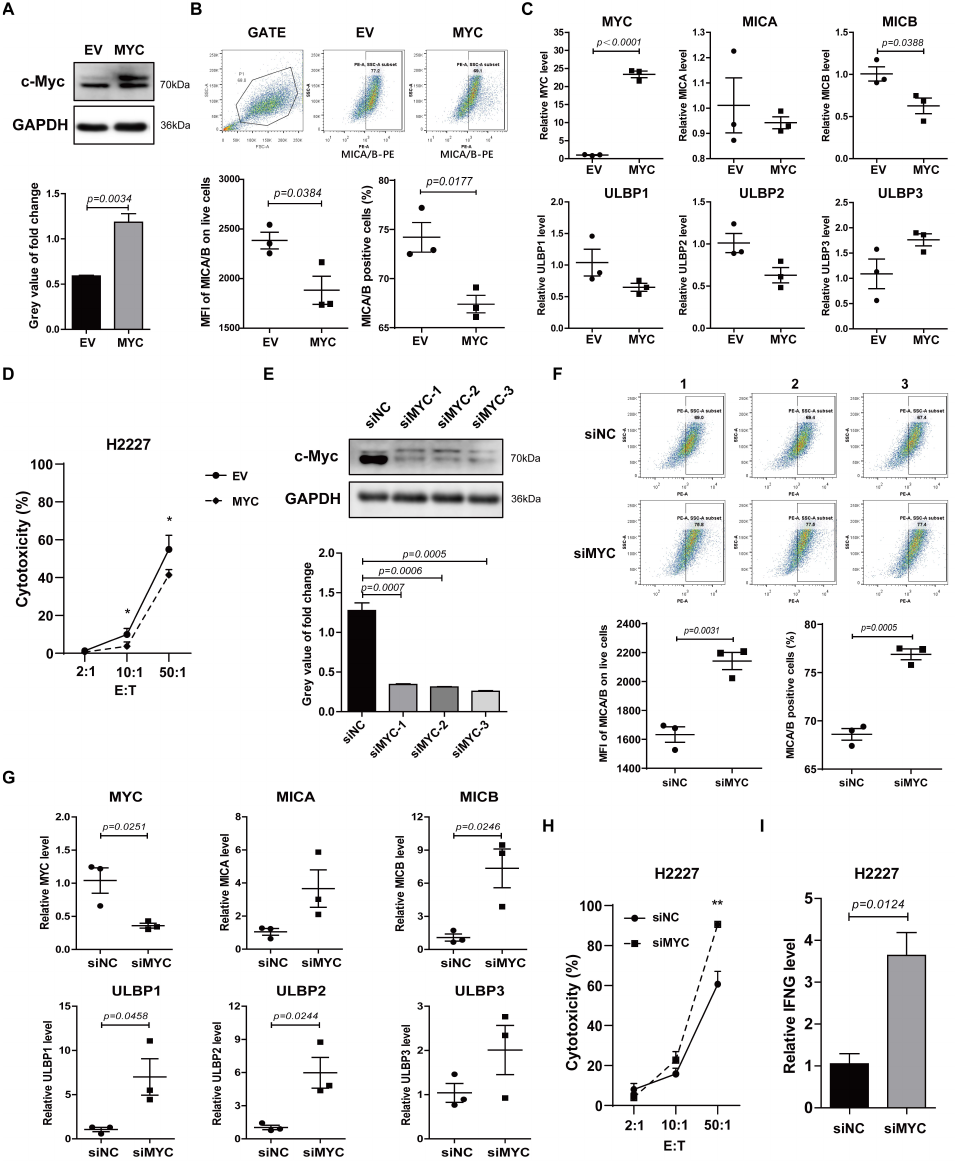
Figure 2. c-Myc was a negative regulator of NKG2DL in H2227 cells. H2227 cells were transfected with MYC-OE or MYC siRNAs (40 pmol/mL). ( A , E ) Western blotting analysis of the c-Myc expression levels in the transfected H2227 cells. ( B , F ) Flow cytometry analysis of MICA/B expression on the transfected H2227 cells. ( C , G ) qRT-PCR analysis of MYC , MICA , MICB , and ULBP1-3 mRNA expression levels in H2227 cells after transfected with MYC-OE or MYC siRNA-3, respectively. ( D , H ) LDH analysis of the susceptibility of transfected H2227 cells to NK-92MI cell killing. ( I ) qRT- PCR analysis of IFNG mRNA expression levels in the transfected H2227 cells. Data are represented as mean ± SD ( n = 3). *, p < 0.05; **, p <